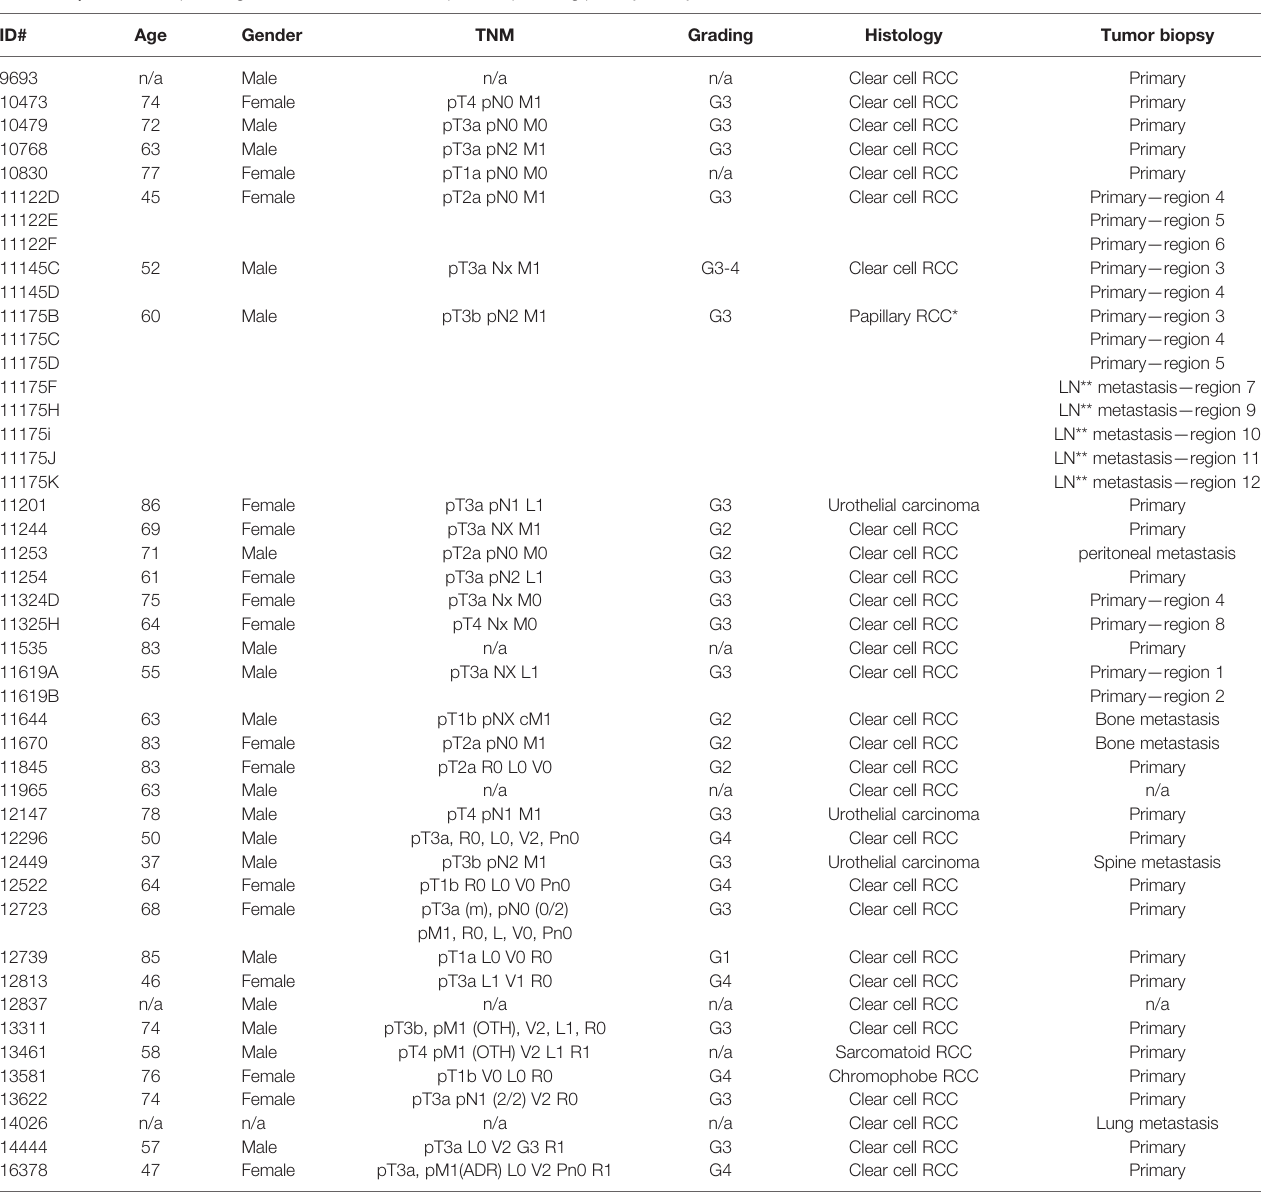
TABLE 1 | Clinical and pathological characteristics of RCC patients providing primary kidney tumor tissue for the establishment of PDX